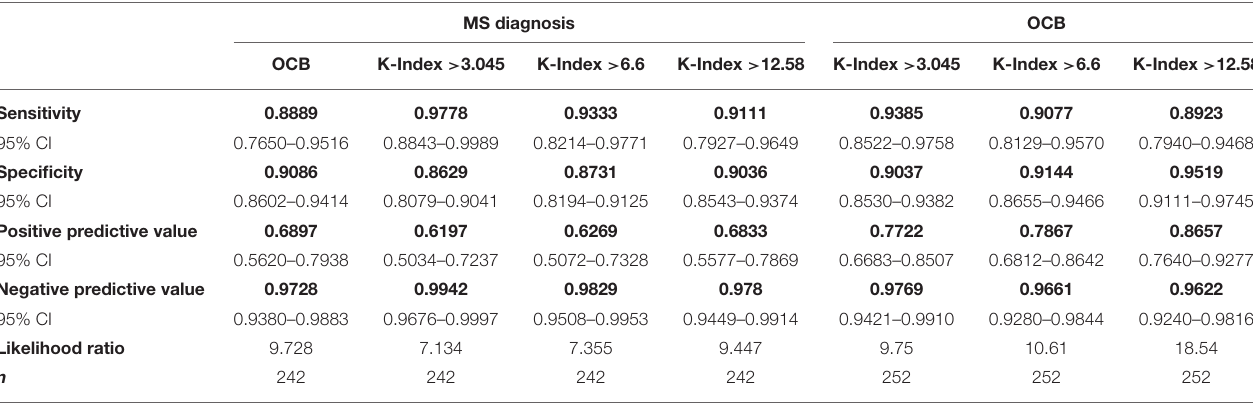
TABLE 2 | Contingency characteristics of OCB testing for MS diagnosis and of different K-Index cutoffs for both MS diagnosis and OCB status. MS